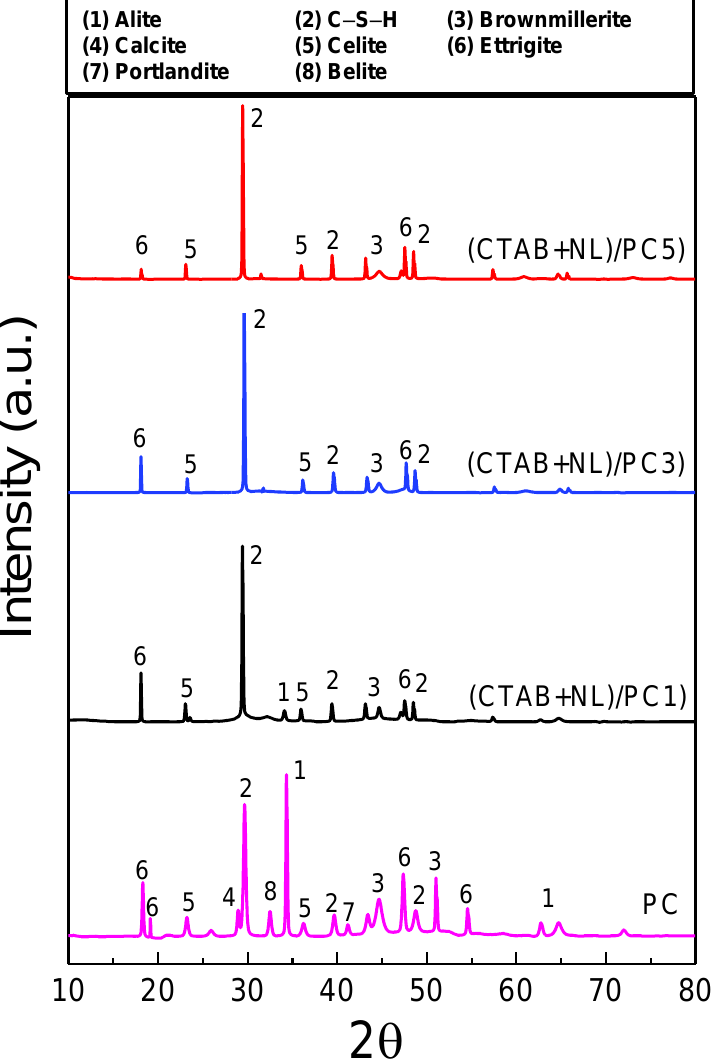
Figure 5. XRD patterns of the PC and (CTAB + NL)/PC1, (CTAB + NL)/PC3, and (CTAB + NL)/PC5 composites after 28 d of curing time.